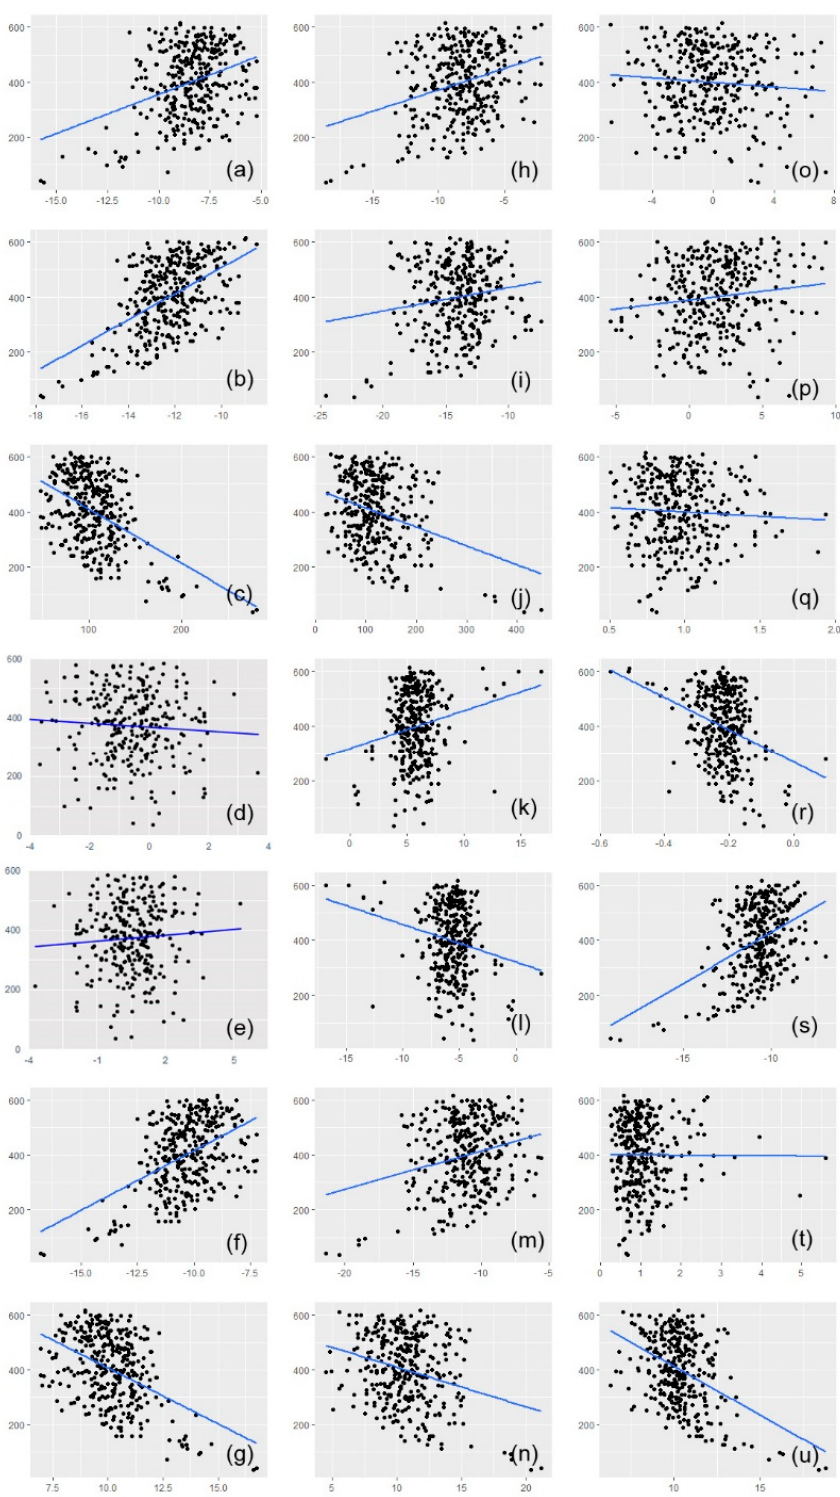
Figure 9. Scatter plots of simple linear correlations between AGB ( y -axis) and image variables ( x -axis).